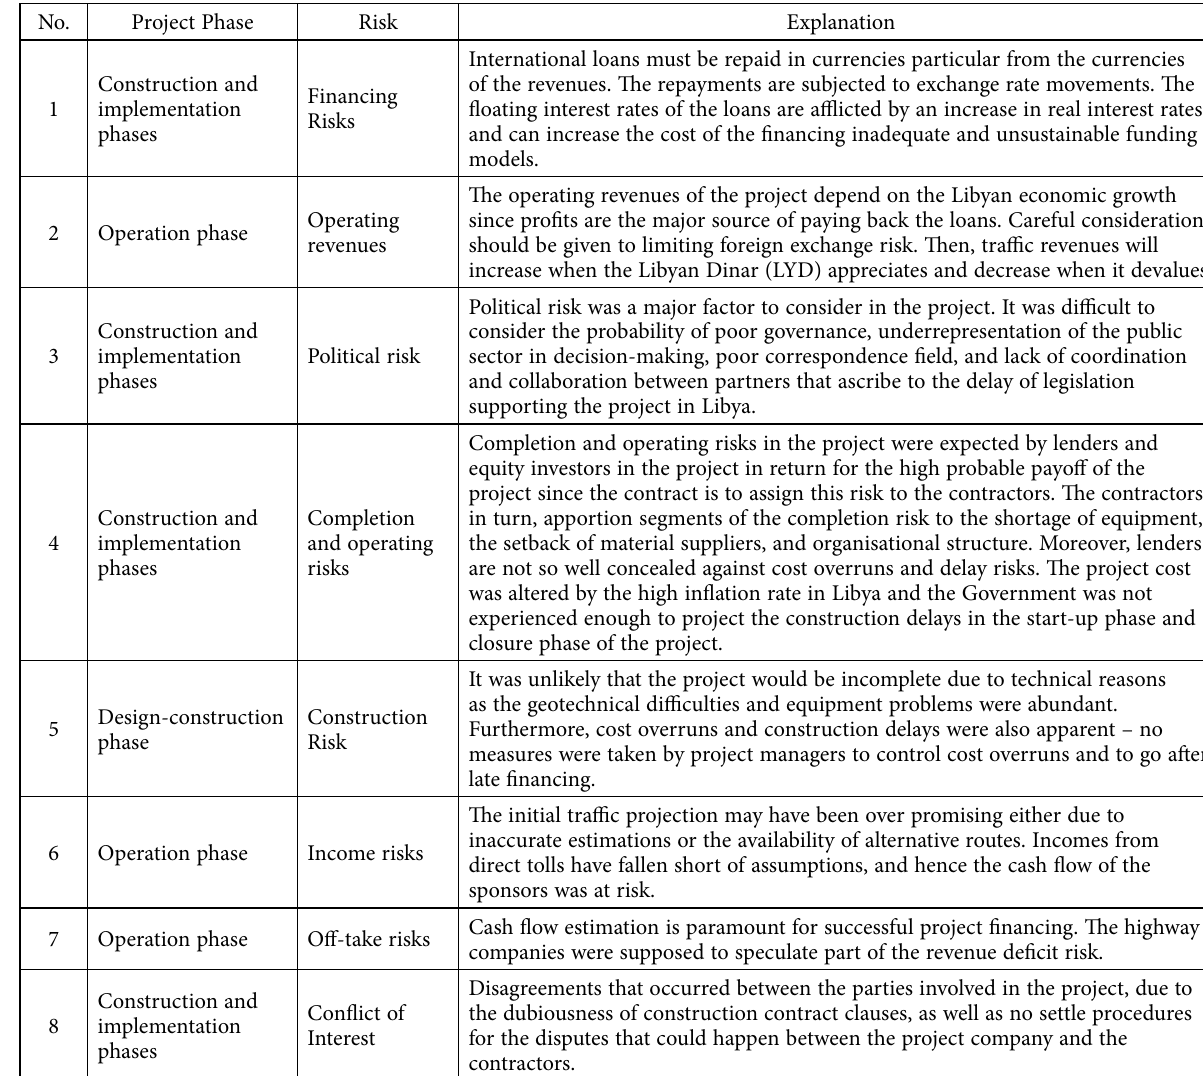
Table 5. Risks encountered in the Tripoli-Benghazi Toll